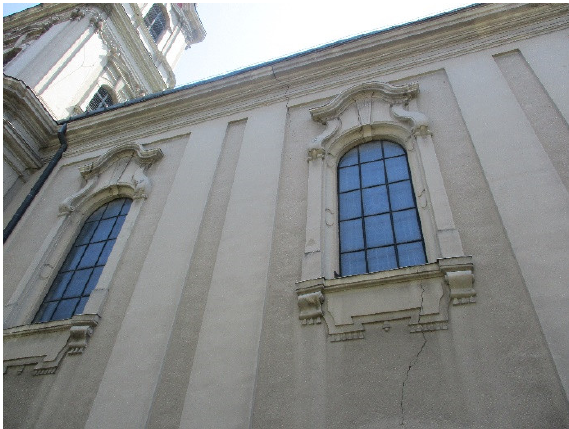
Figure 3. Cracks in the longitudinal wall—north facade.